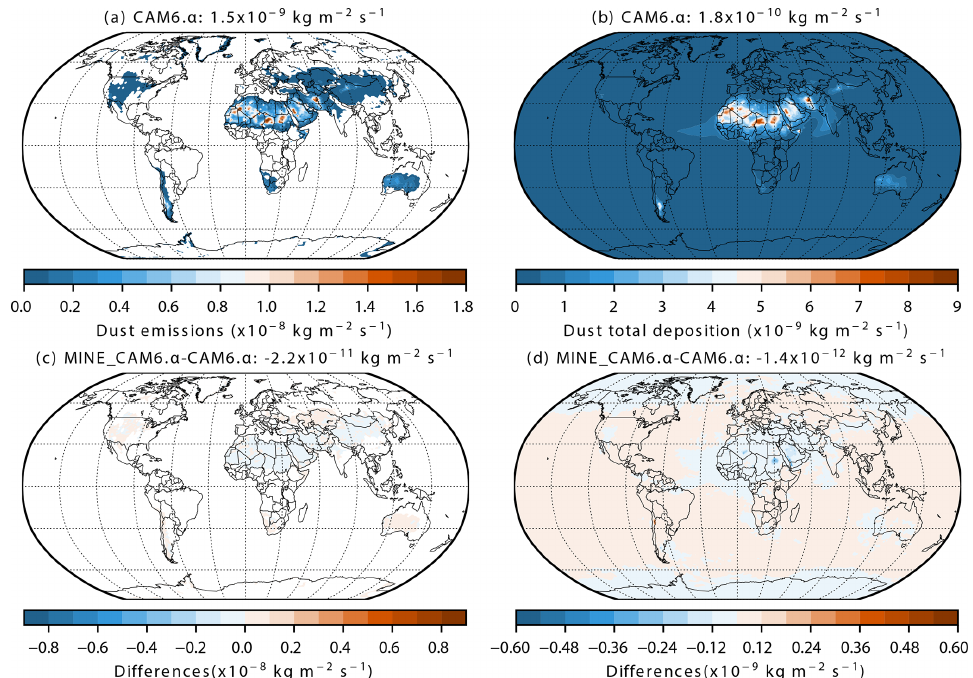
Figure 12. Surface dust emissions ( a ; global annual mean = 2891Tg) and deposition fluxes ( b ; global annual mean = 2893Tg) simulated by CAM6. α and their differences ( c and d ) between CAM6. α _MINE and CAM6. α